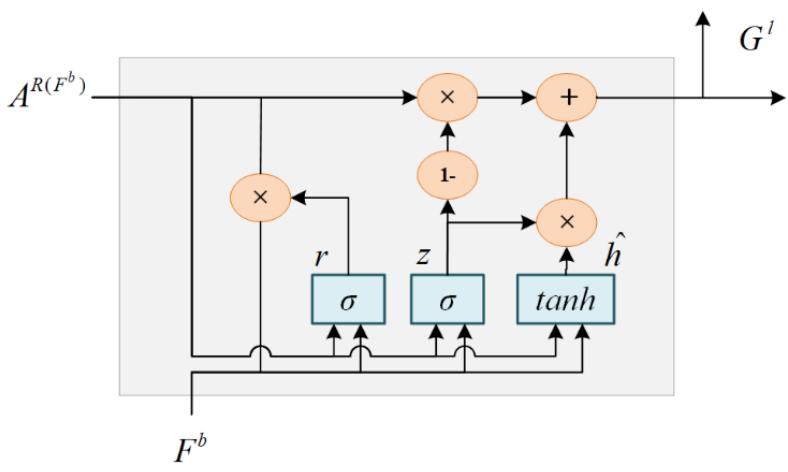
Figure 5. Internal computing structure of GRU.